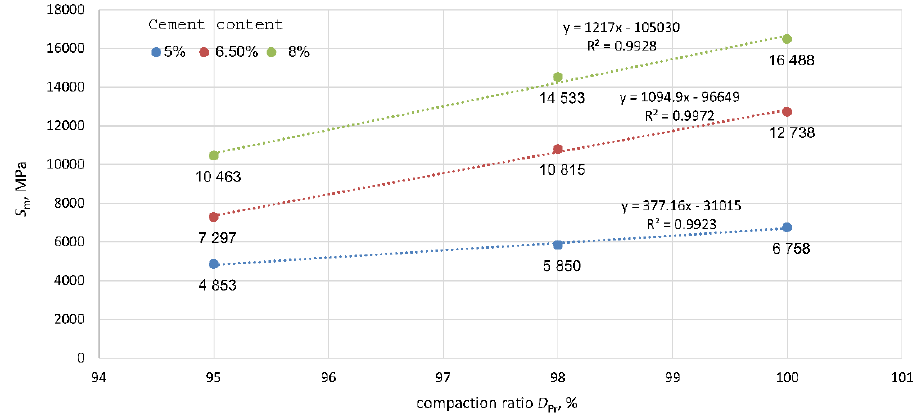
Figure 10. Influence of the compaction ratio, 𝐷 𝑃𝑟 , on the value of the dynamic stiffness modulus, 𝑆 𝑚